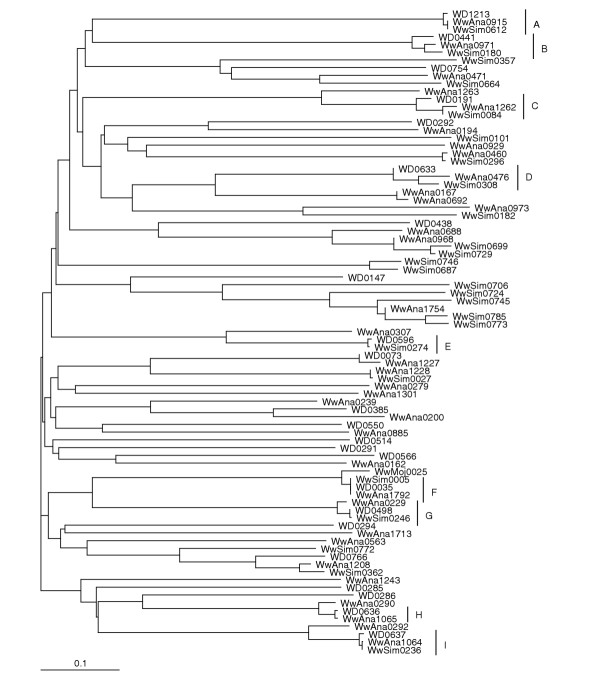
Relationship of ankyrin repeat domain proteins between wMel, wAna, wSim and wMoj. All the predicted ankyrin repeat proteins with greater than 120 amino acids were aligned and clustered using ClustalW. Nine predicted ankyrin repeat domain proteins (A-I) were found to be conserved among at least wMel and one other of these Wolbachia species with nucleotide sequence identity > 95% across the entire length of the gene.